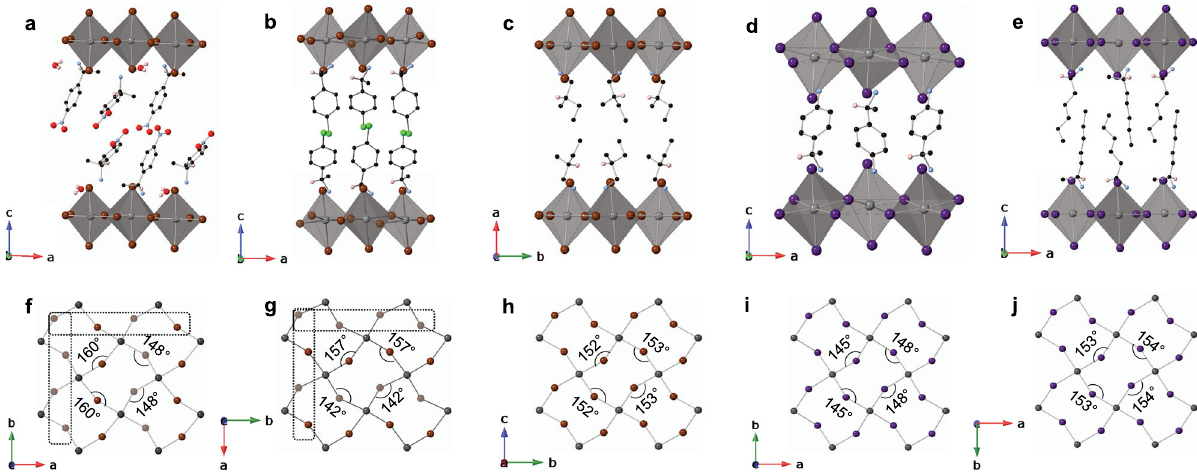
Fig. 2 Structural characteristics of chiral MHPs. a – e Schematic single-crystal X-ray structures of [S-4-NO 2 -MBA] 2 PbBr 4 .H 2 O ( a ), [R-4-Cl-MBA] 2 PbBr 4 ( b ), [S-2-Me-BuA] 2 PbBr 4 ( c ), [S-4-NH 3 -MBA]PbI 4 ( d ), and [S-MHA] 2 PbI 4 ( e ). In each case, all H atoms except the one on the chiral carbon stereocenter are omitted for clarity. f – j In-plane views of perovskite layers corresponding to ( a – e ) showing the equatorial Pb – X – Pb bond angles ( β ). Axial X atoms are omitted for clarity. The two distinct equatorial Br atoms associated with widely disparate β angles in ( f , g ) are distinguished by shaded and solid spheres. The dashed rectangles differentiate the individual rows comprised of the same type of equatorial Br atoms from the rows comprising alternating types of equatorial Br atoms, highlighting the local geometry fl uctuation along one of the in-plane directions. In ( h – j ), the two unique equatorial X atoms are geometrically nominally equivalent with similar β angles. Gray, brown, purple, red, green, blue, black, and pink spheres denote Pb, Br, I, O, Cl, N, C, and H atoms, respectively.